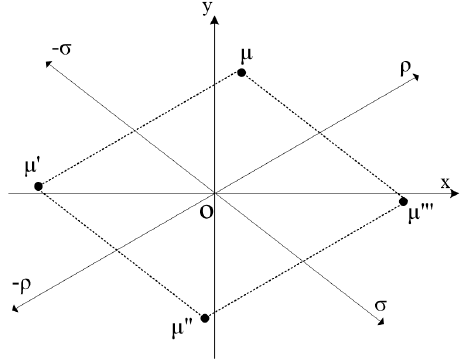
Figure 3. Vectors of copies of node 0.